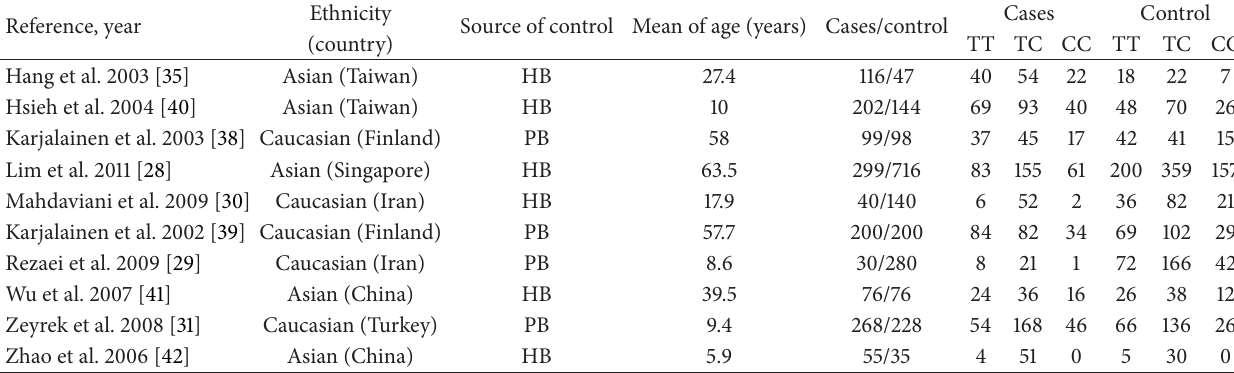
Table 1: Main data of all studies included in the meta-analysis for the -511C/T polymorphism in IL-1 𝛽 gene.